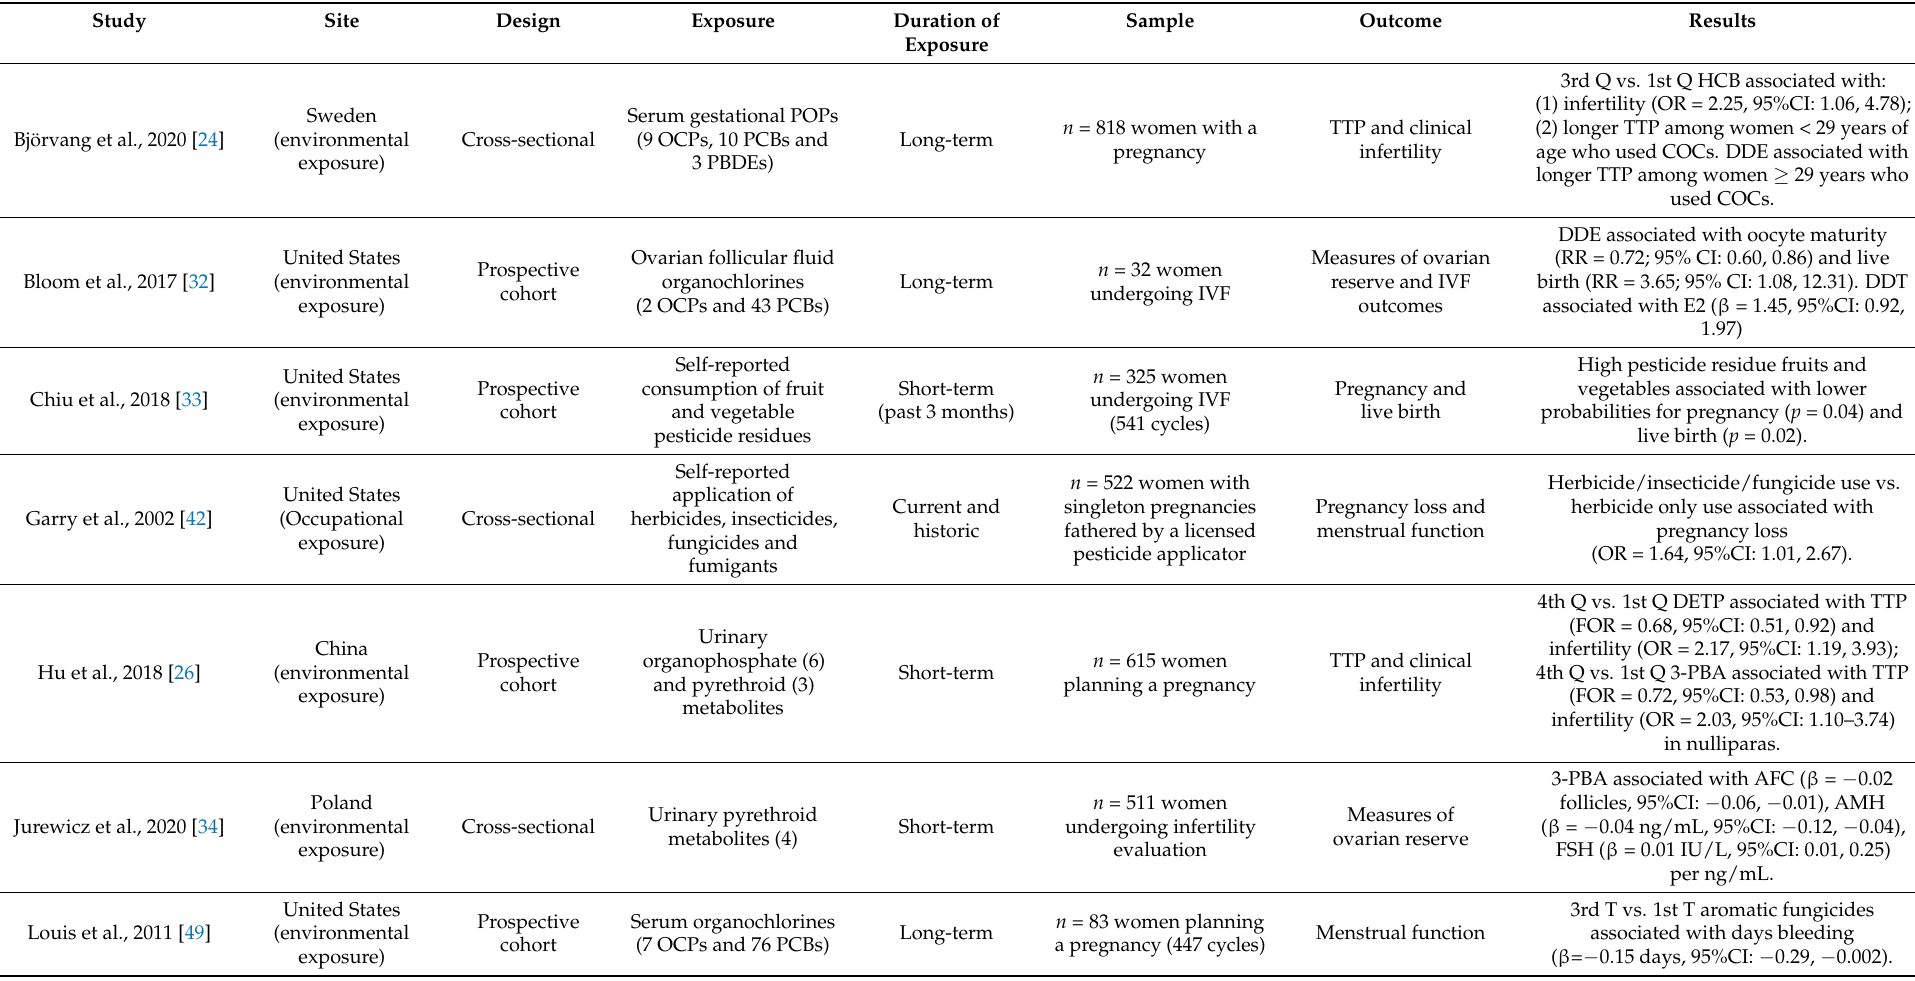
Table 1. Epidemiologic studies estimating associations between pesticide exposure and female